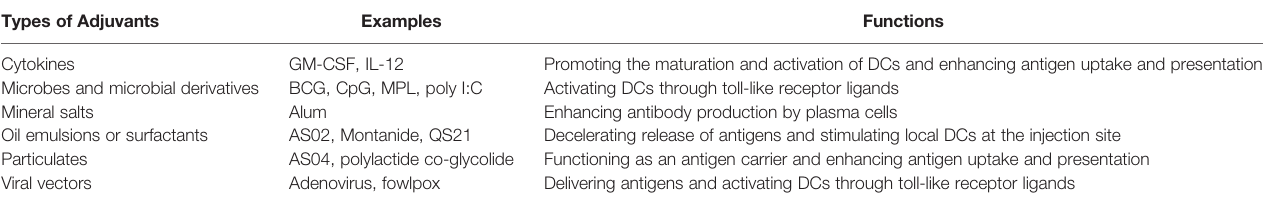
TABLE 1 | Major types of adjuvants for breast cancer vaccine and their functions. Types of